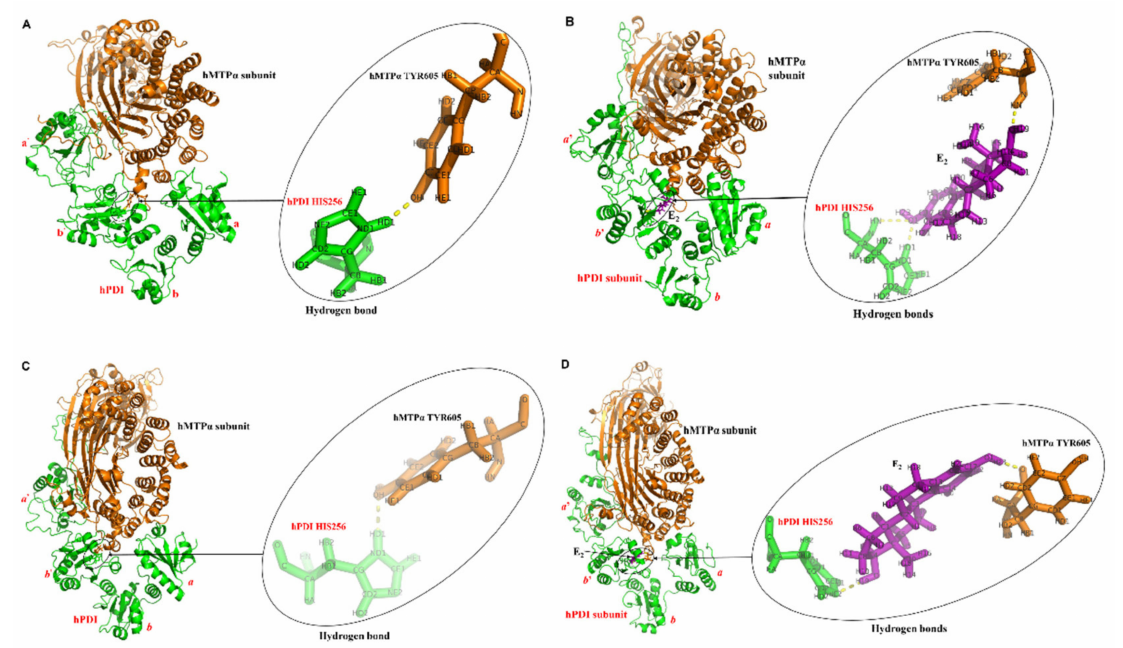
Figure 2. Conformations of hMTP and hMTP–E 2 complexes after molecular dynamics (MD) simulations. For convenience, MD simulations with and without a hydrogen bond constraint are called as the first and second MDs, respectively. ( A ) hMTP complex after the first MDs. ( B ) hMTP–E 2 complex after the first MDs. ( C ) hMTP complex after the second MDs. ( D ) hMTP–E 2 complex after the second MDs. The hMTP α subunit, hPDI and E 2 are colored in orange, green and purple,